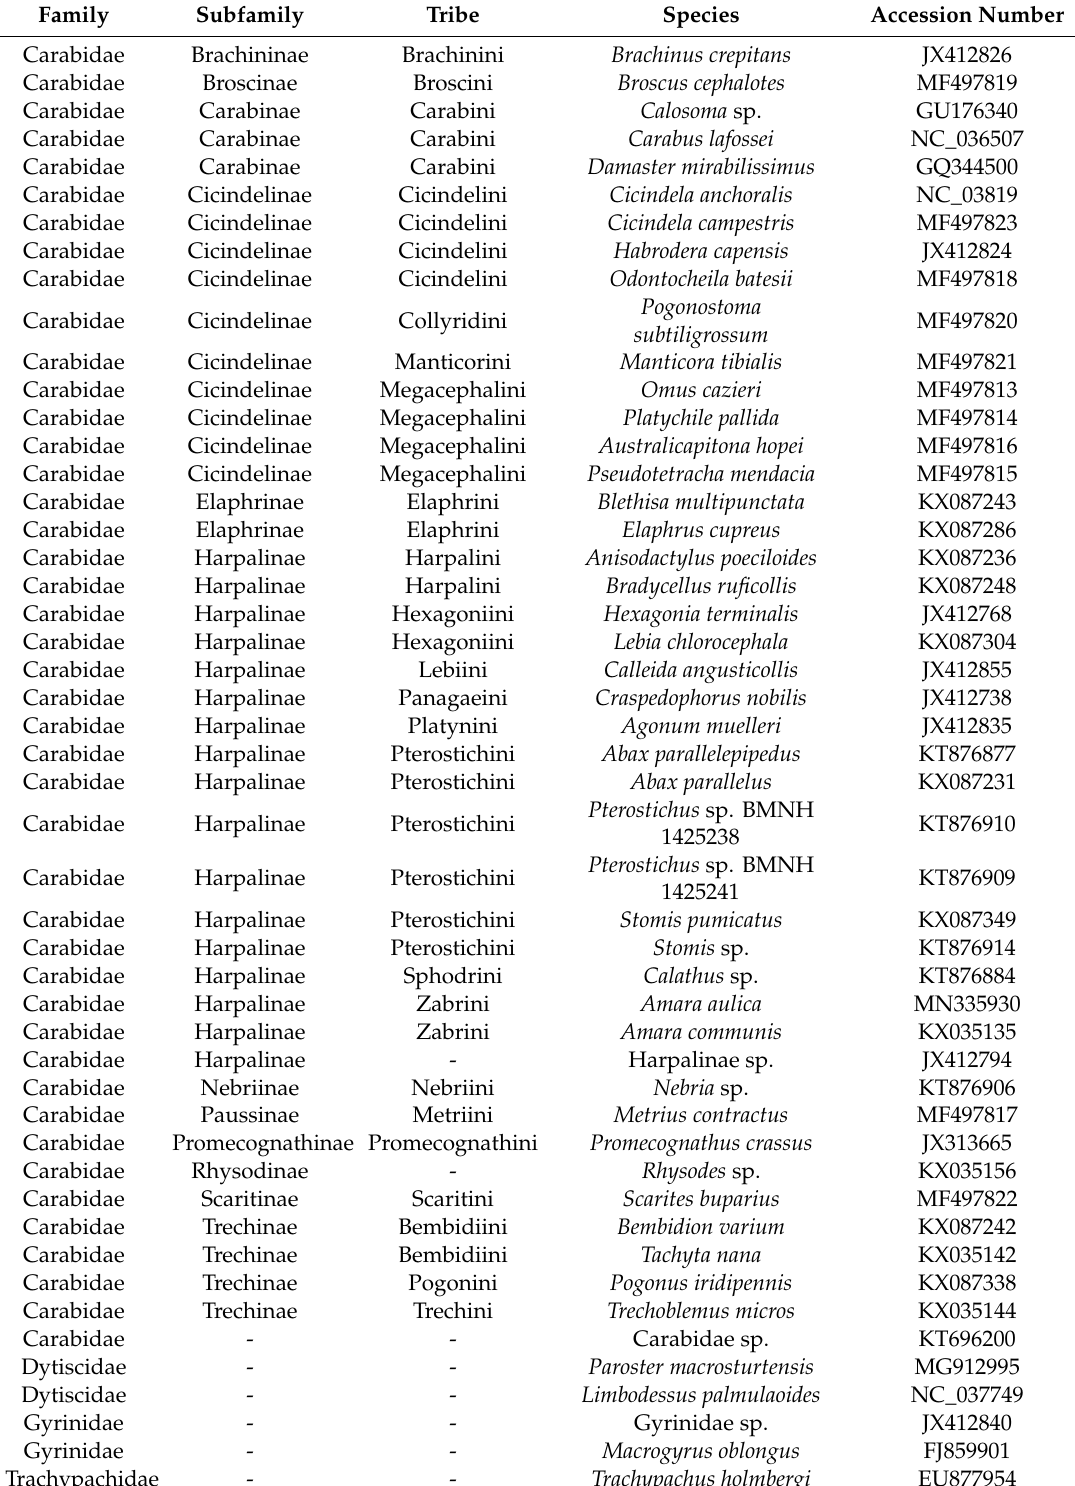
Table 2. List of the species included in this